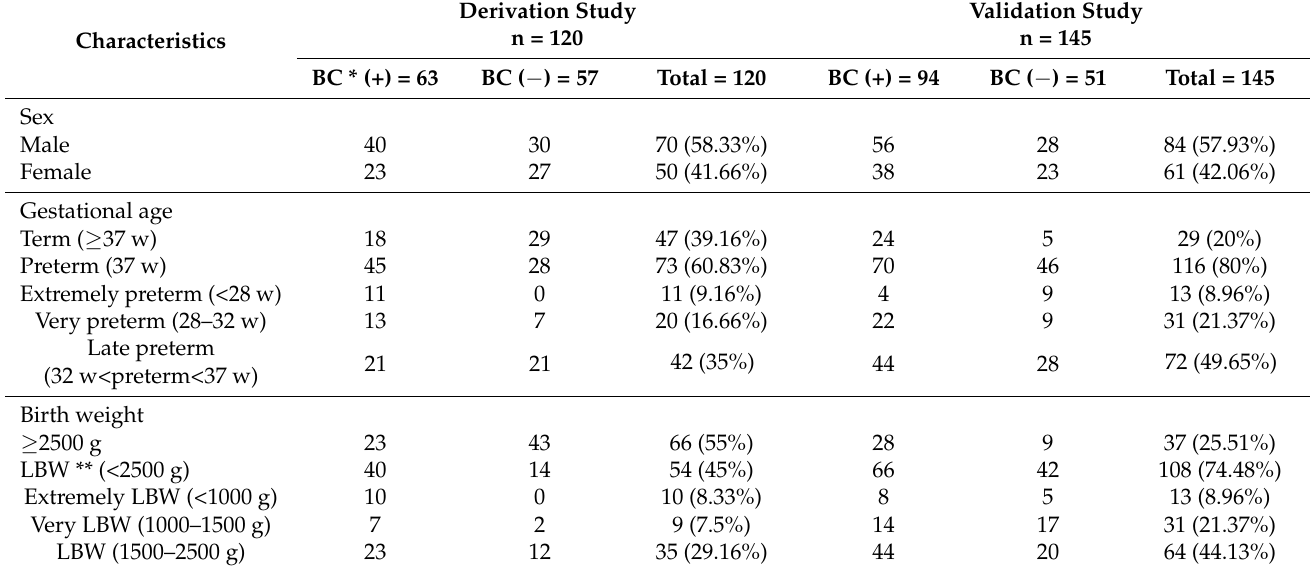
Table 1. Demographic data of neonates in derivation (2010) and validation (2017–2019) part of the